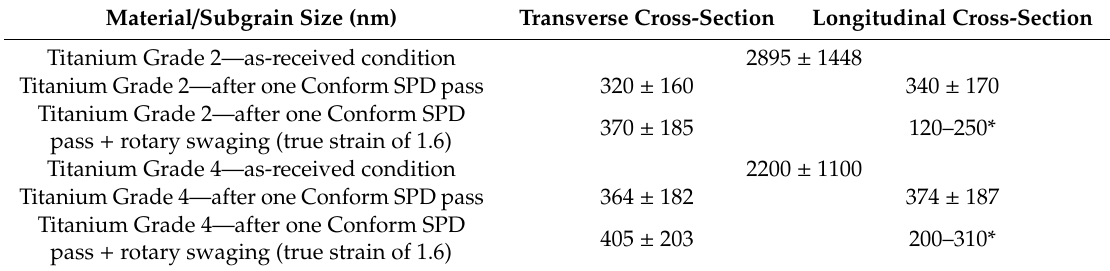
Table 2. Subgrain sizes in the materials as estimated from TEM